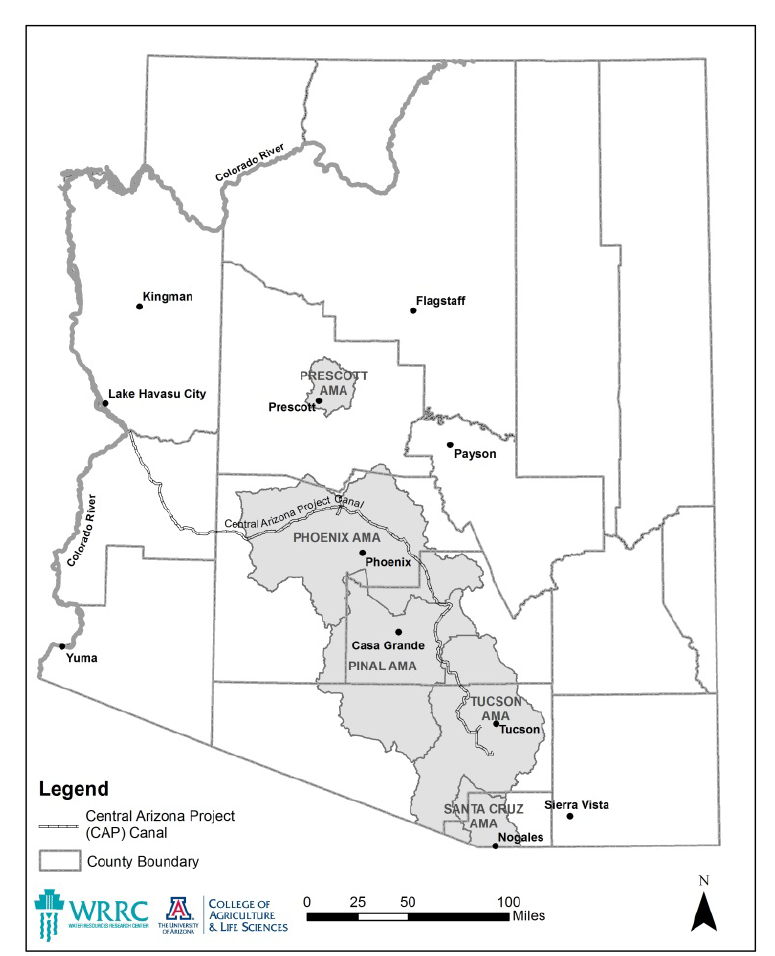
Figure 1. Map of Arizona showing the Active Management Areas (AMAs) and county boundaries. Source: Water Resources Research Center, The University of Arizona